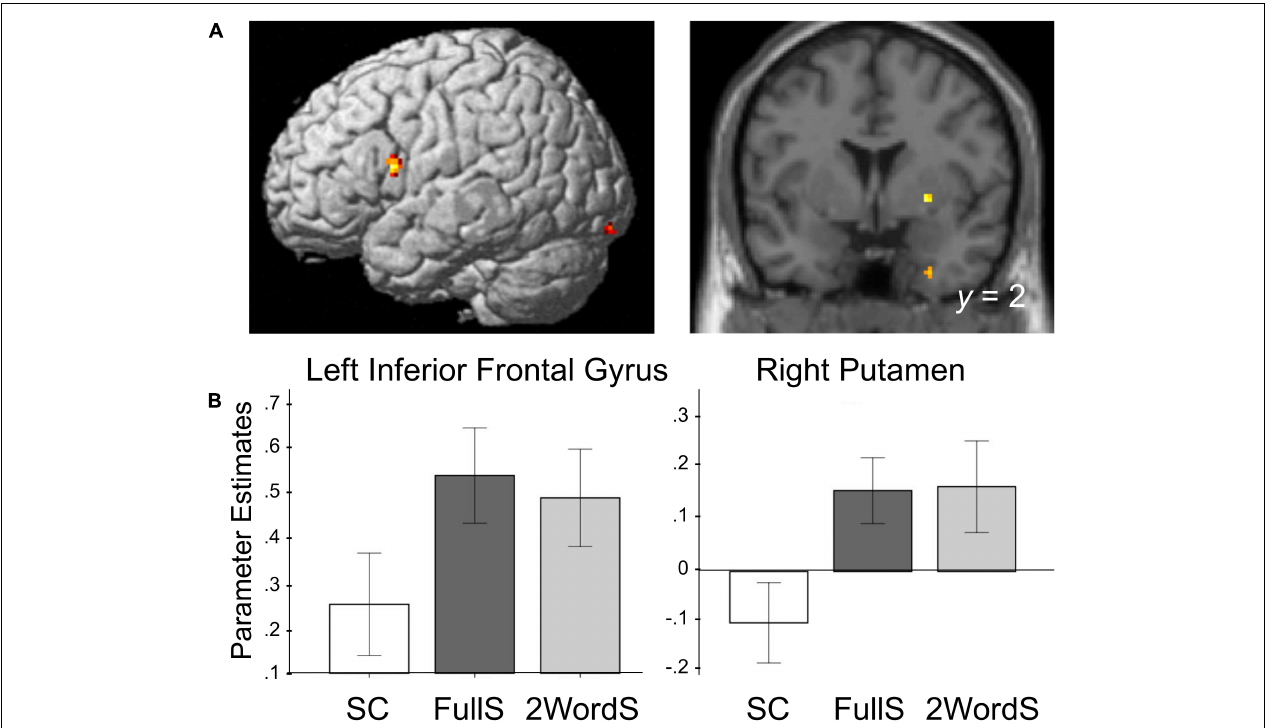
FIGURE 2 | Processing of Small Clauses is associated with reduced activation in the left IFG (BA 44) and the right putamen. (A) Activation maps are rendered on a brain template depicting brain regions in which activation for Small Clauses was lower compared to activation for Full Sentences and for Two-word Sentences. These brain regions include regions in the Inferior Frontal Gyrus ( x = –48, y = 8, and z = 16) and the Putamen ( x = 26, y = 2, and z = –2). Conjunction analysis was made using contrast maps of Small Clauses compared to Full Sentences, and Small Clauses compared to Two-word Sentences, each threshold at p < 0.005 (conjunctive p < 0.000025). Clusters identified by the conjunction composed of at least 9 contiguous voxels are reported. (B) Mean parameter estimates per condition extracted from the functionally defined regions of interest identified in the conjunction analysis shown in A . SC, Small Clauses; FullS, Full Sentences; 2WordS, Two-word